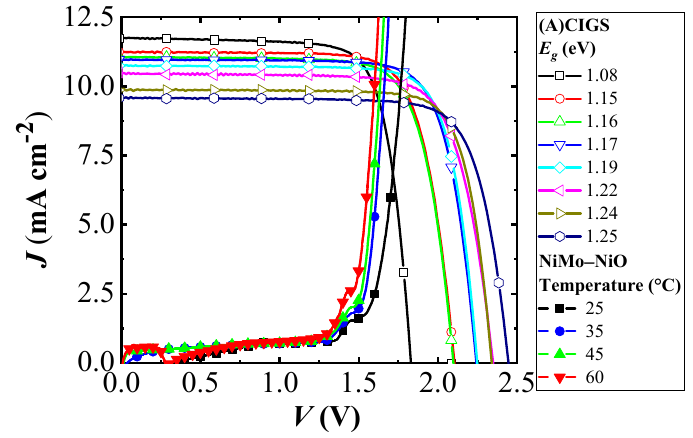
Figure 5. Current density versus potential for three-cell (A)CIGS modules with different band gap energies of the sub-cells and the load curve for the NiMo–NiO electrolyzer at different temperatures. The open circuit potential of the three-cell modules naturally follows the increased voltage of each sub-cell with V OC , increasing from 1.83 to 2.45 V with increasing band gap (Figure 6a). The short-circuit current density ( J sc ) of the (A)CIGS modules (Figure 6b) decreased from 11.8 to 9.6 mA cm − 2 with increasing band gap. The efficiency ( 𝜂 ) of the (A)CIGS modules (Figure 6c) varied between 16.44% and 19.04% for the studied band gap range. There is a trend between the efficiency and band gap showing a maximum for mid-band gap and successive lowering with increasing and decreasing band gaps. The lowest efficiency was obtained for the module with the lowest band gap energy and the highest efficiency could be obtained for the module with a moderate band gap energy, which was 1.17 eV. There was no clear trend between the fill factor ( 𝐹𝐹 ) and band gap (Figure 6d), varying between 0.76 for 1.16 eV and 0.80 for 1.24 eV.